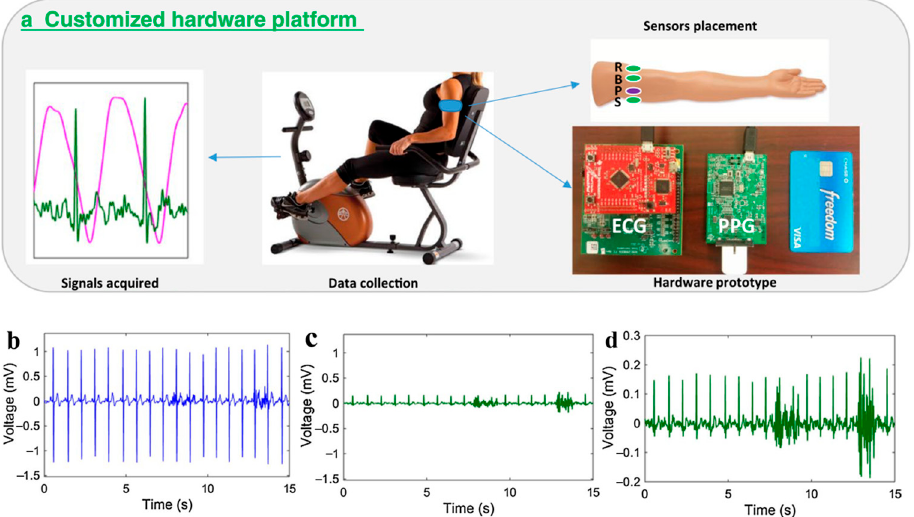
Figure 12. ( a ) Customized hardware platform; ( b ) chest-ECG; ( c , d ) arm-ECG. Reproduced with the permission of [70].